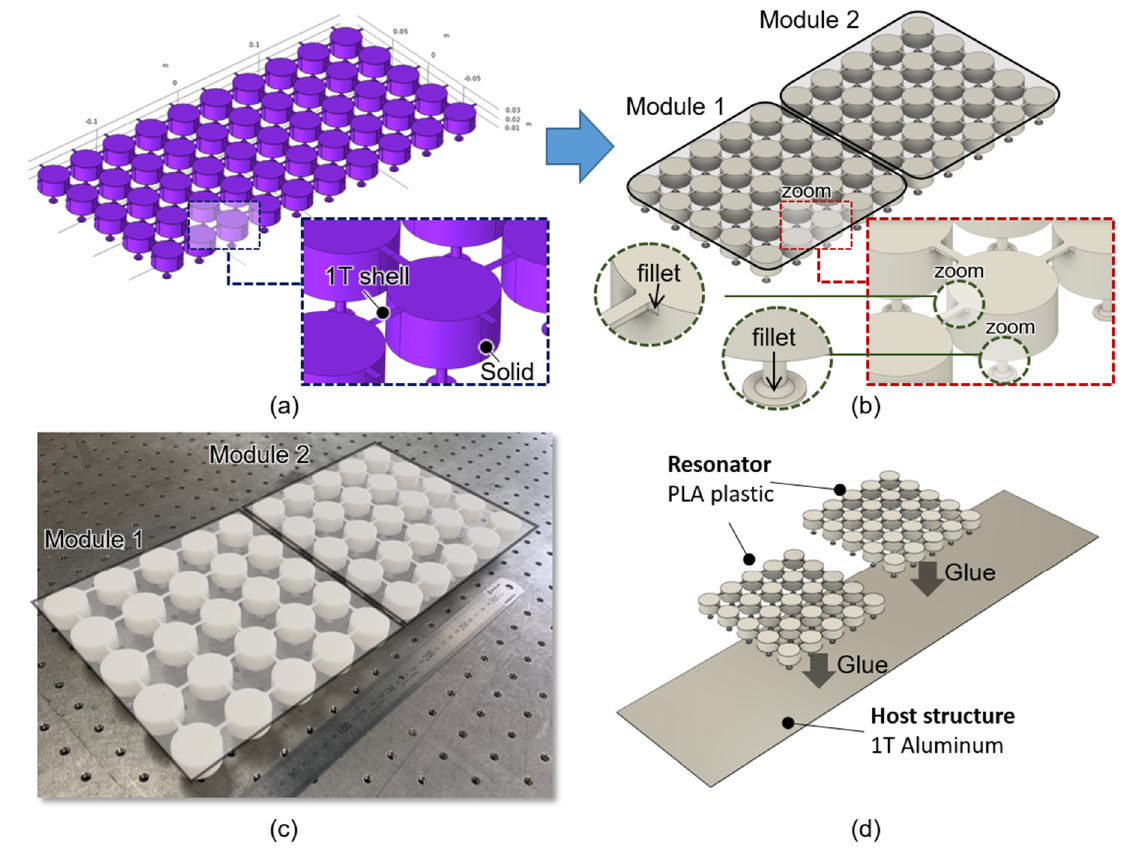
Figure 8. Fabrication process of the interconnected metamaterial, using ( a ) a numerical analysis model; ( b ) modified model for additive manufacturing; ( c ) assembly scheme of the 5 × 5 multi-celled metamaterial and host structure; ( d ) assembly schematics of metamaterial .